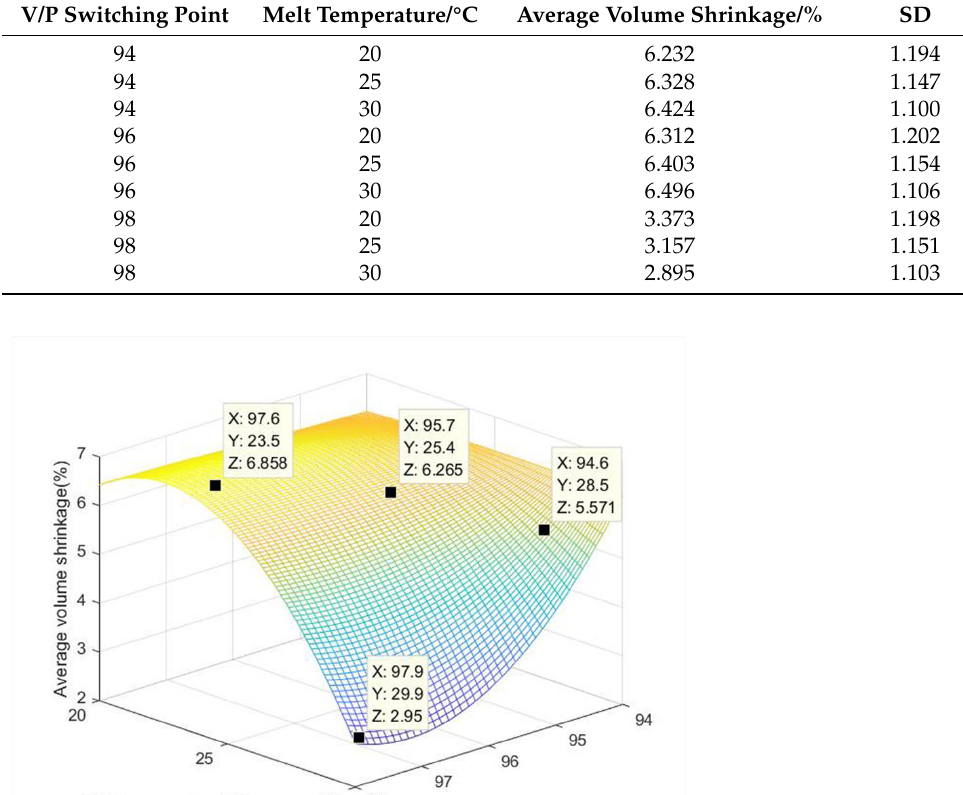
Table 7. Relationship between volume contraction and fingerprint.